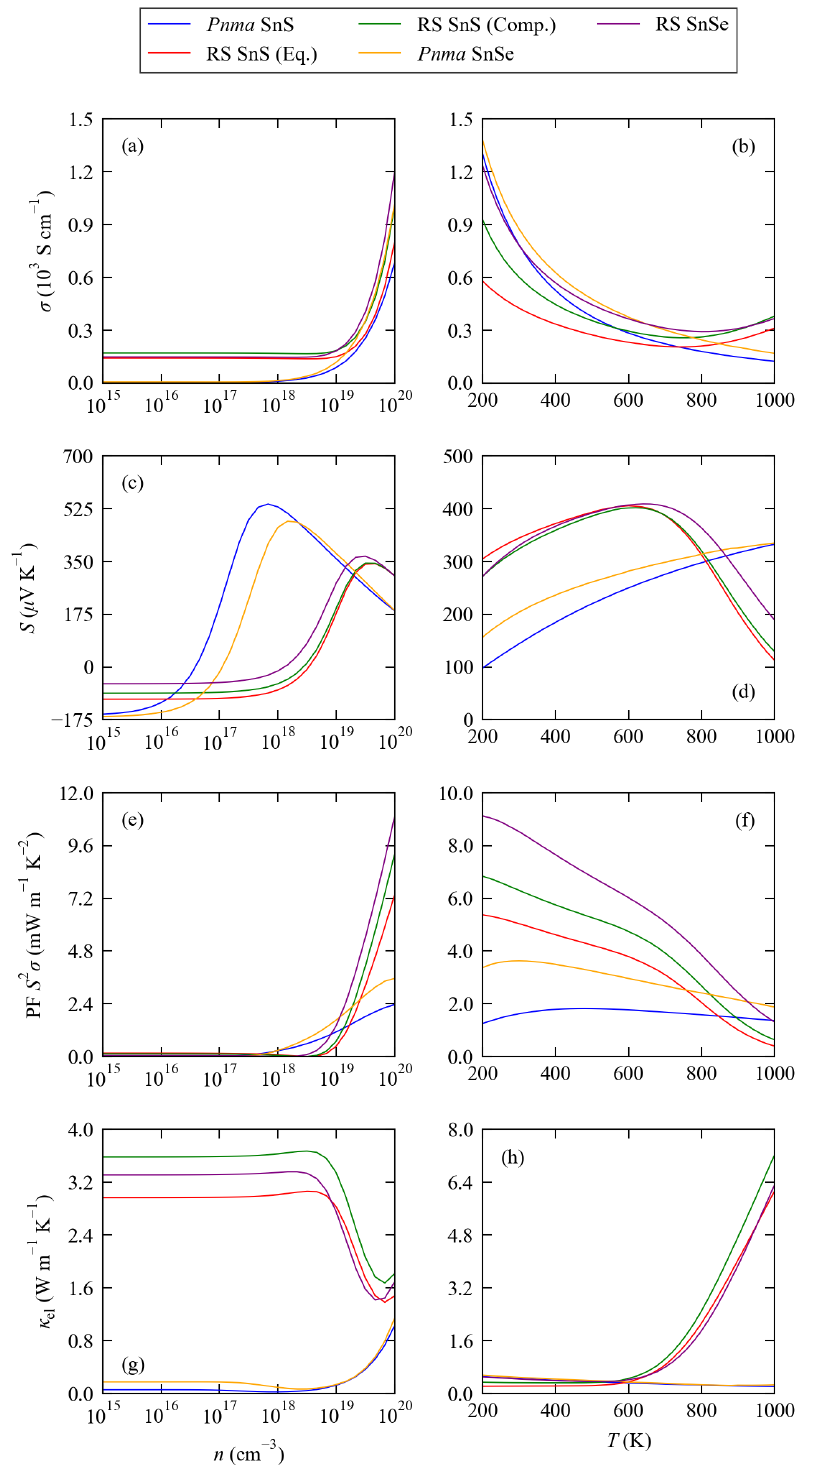
Figure 3. Comparison of the calculated electrical conductivity σ ( a , b ), Seebeck coefficient S ( c , d ), power factor S 2 σ (PF) ( e , f ), and electronic thermal conductivity κ el ( g , h ) of the five structures exam- ined in this work. For each structure, we show the scalar averages computed using Equations (9)–(11). The four properties are compared as a function of carrier concentration n for a fixed T = 800 K ( a , c , e , g ) and as a function of temperature for a fixed n = 2.15 × 10 19 cm − 3 ( b , d , f , h